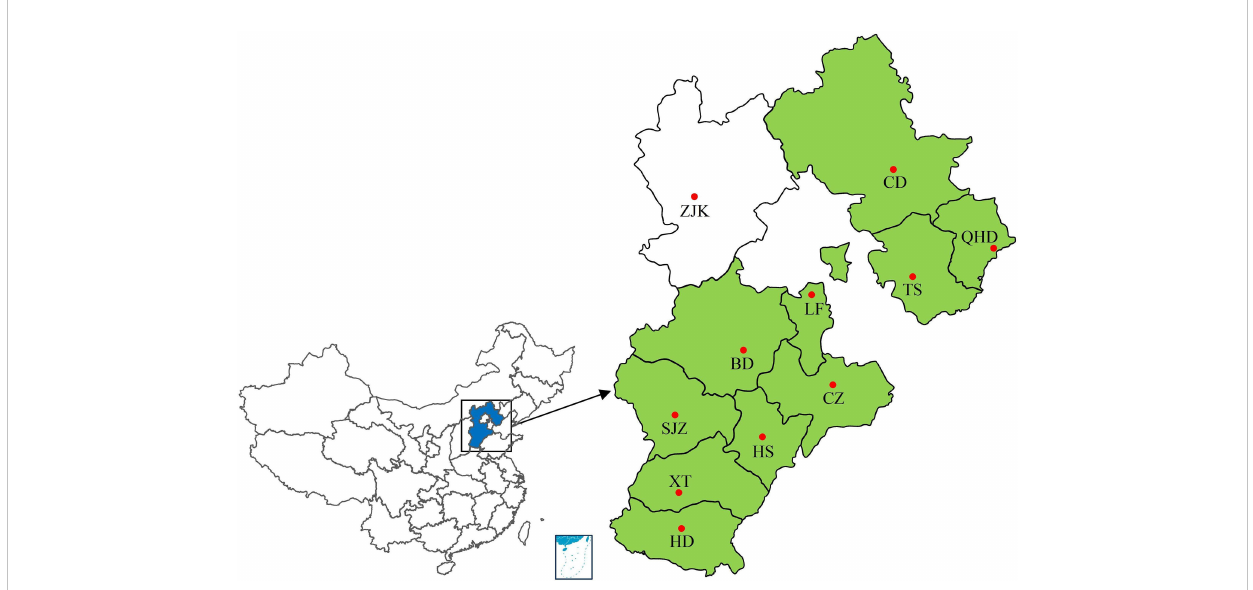
FIGURE 1 Collection sites of wheat leaf rust samples from 2001 to 2010. Colored regions represent regions of sample sources. SJZ, Shijiazhuang; BD, Baoding; LF, Langfang; CZ, Cangzhou; HS, Hengshui; TS, Tangshan; CD, Chengde; XT, Xingtai; HD, Handan; QHD, Qinghuangdao. (cid:129) , location of provincial